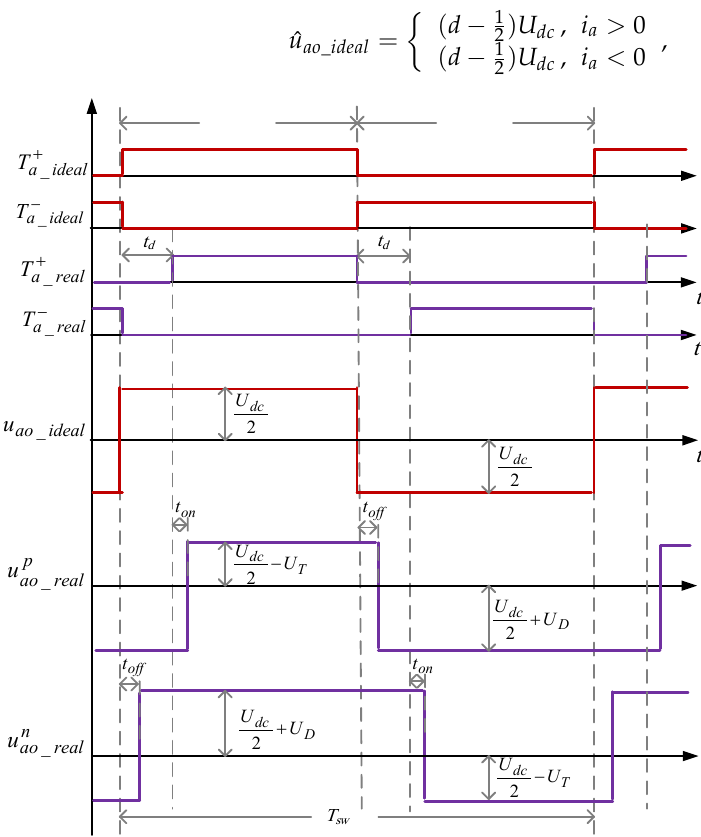
Figure 4. Switching pulses and output voltage for the A-phase during one switching period.